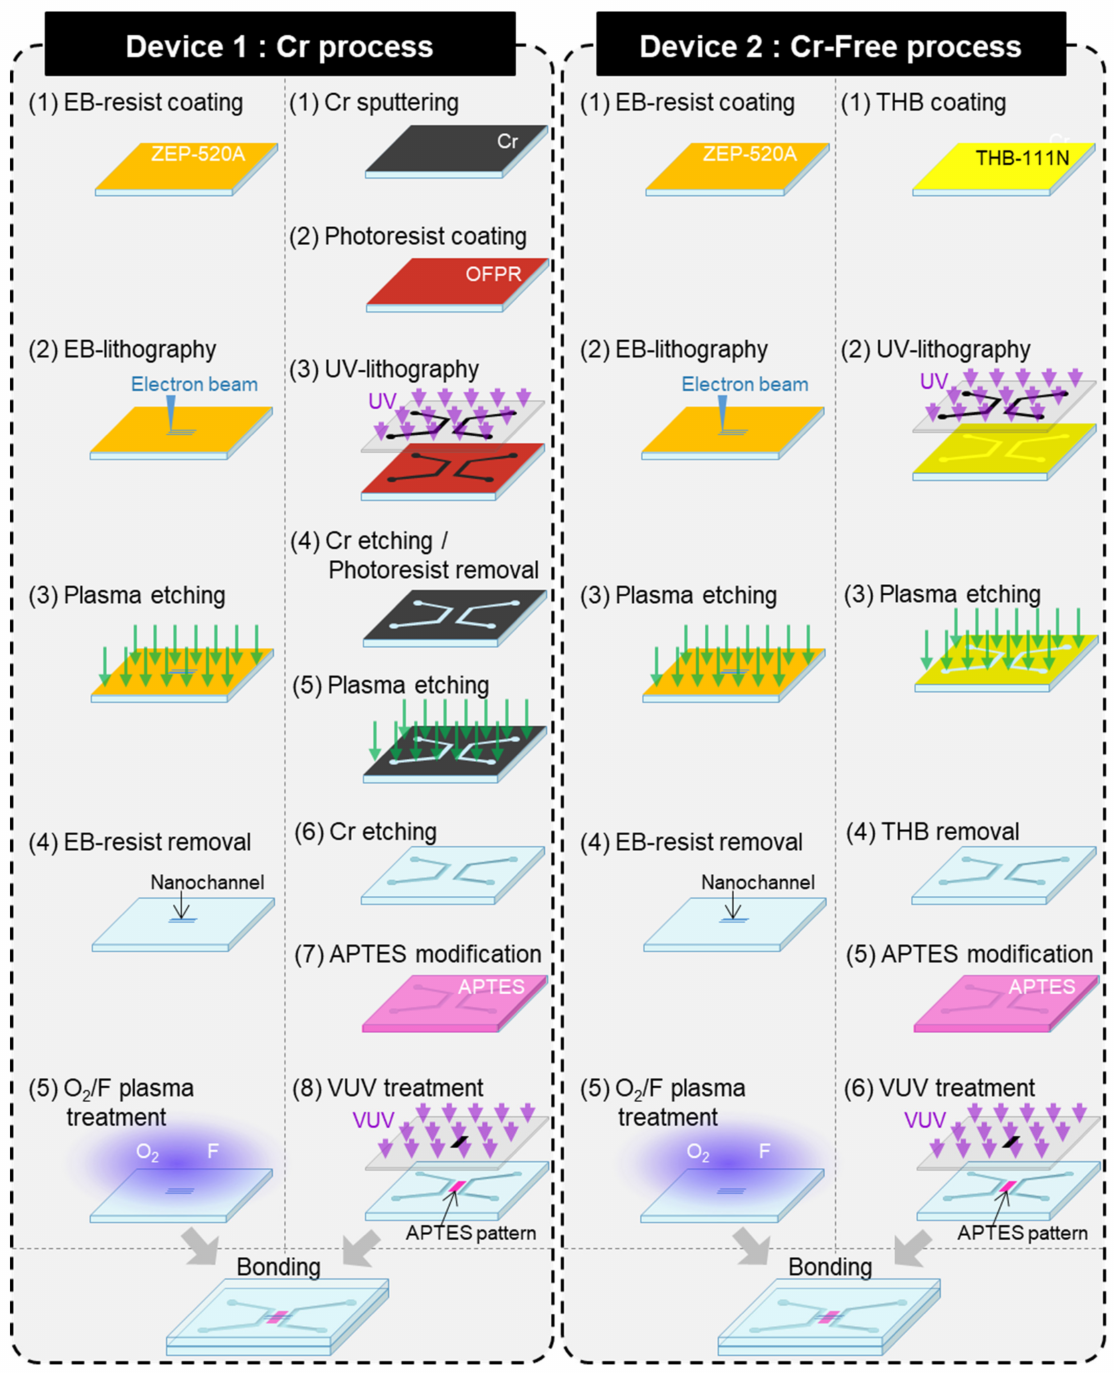
Figure 1. Processes for fabrication of nanofluidic devices using fused silica